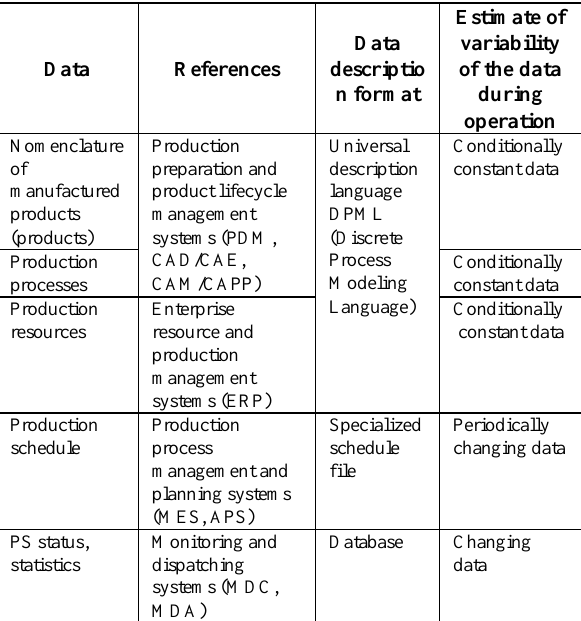
Table 1. Structure of building an information model of the